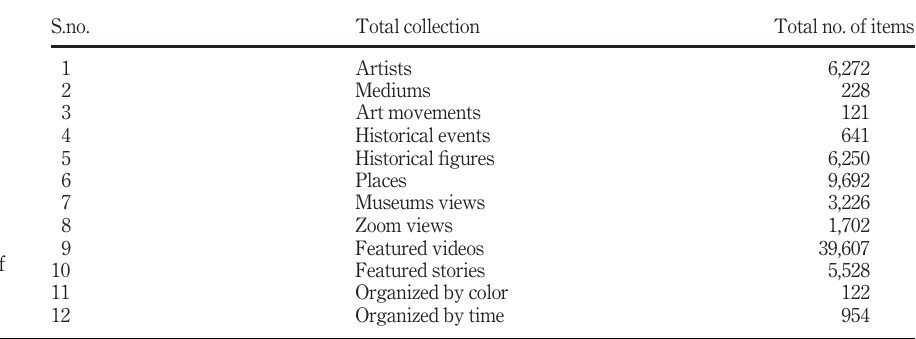
Table I. Total collection of Google Arts and